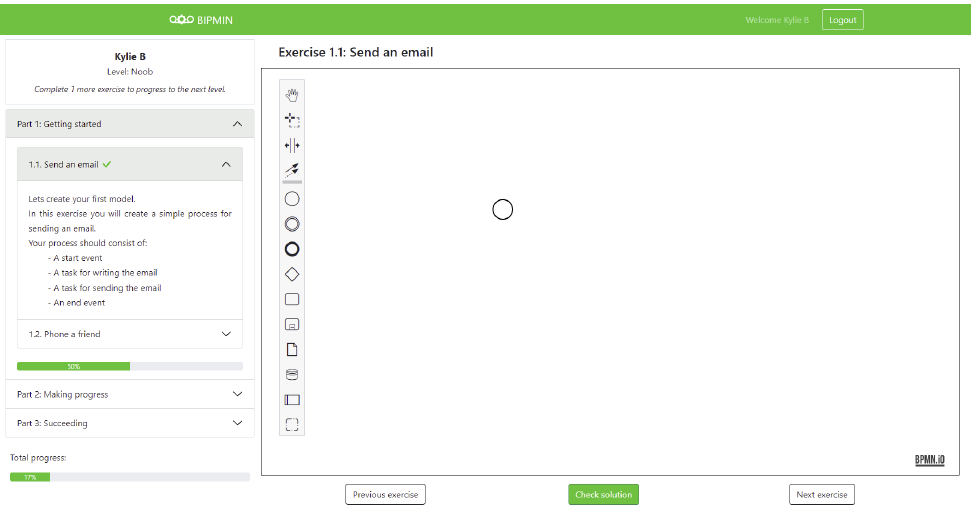
Figure 10. Progress version main